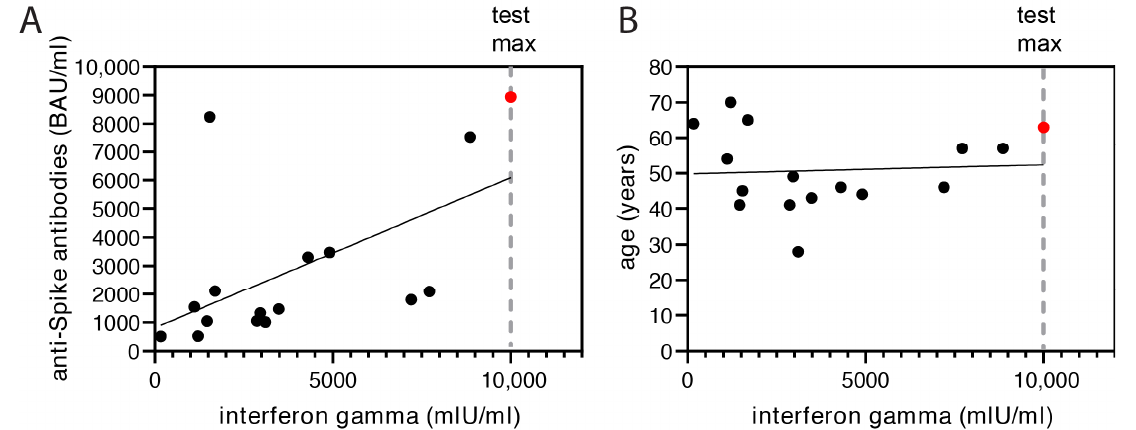
Figure 4. Interferon-gamma release of T cells after the second booster vaccination. Interferon- gamma release assays were performed with 16 subjects 7.3 weeks after the second booster vaccination (Table S1). Interferon gamma concentration is measured in mlU/mL (mIU—milli international units). Results were plotted against ( A ) the anti-Spike IgGs (BAU/mL) (linear regression—R = 0.3) or ( B ) age (years) (liner regression—not significant).